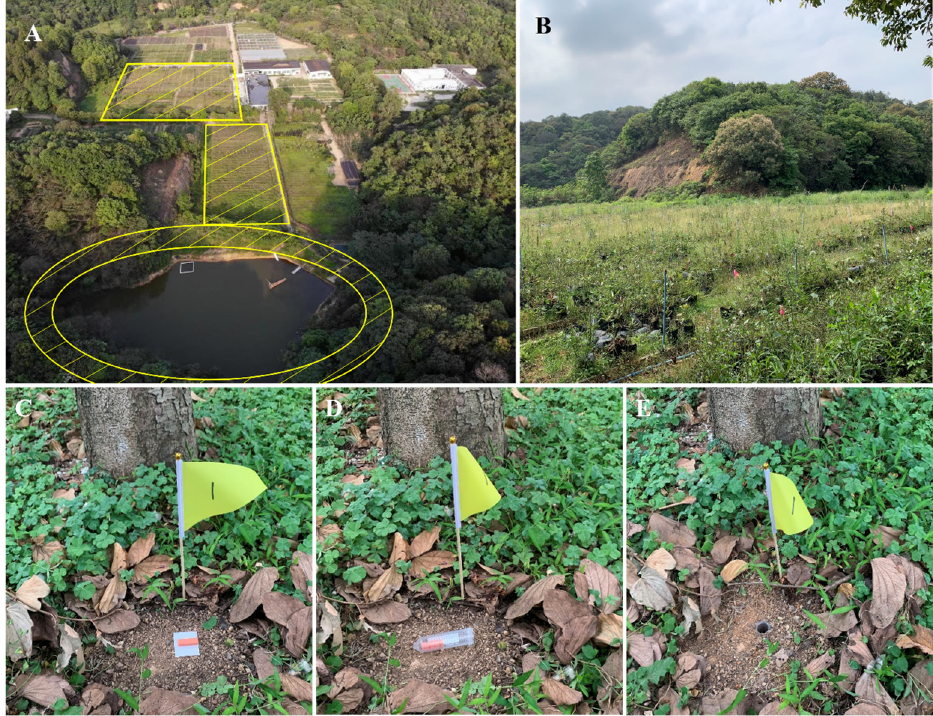
Figure 2. Aerial ( A ) and ground ( B ) views of experimental location one. The adhesive tapes ( C ), baiting tubes ( D ), or pitfall traps ( E ) were placed in each site of the experimental location. The hatched area shows the area where the experiment was conducted.